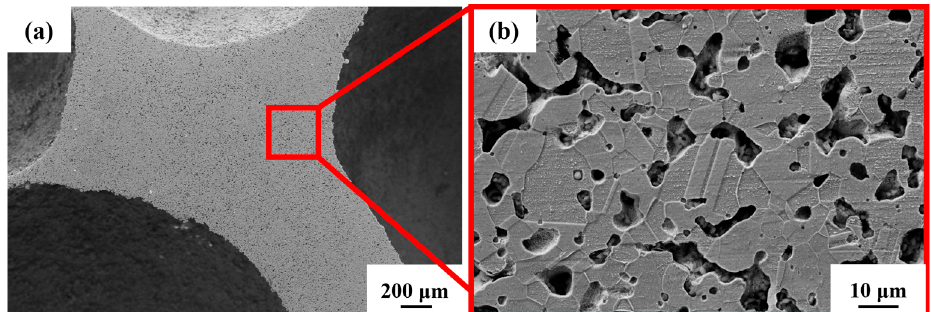
Figure 5. Microstructure of ( a ) steel foam and ( b ) pore wall.